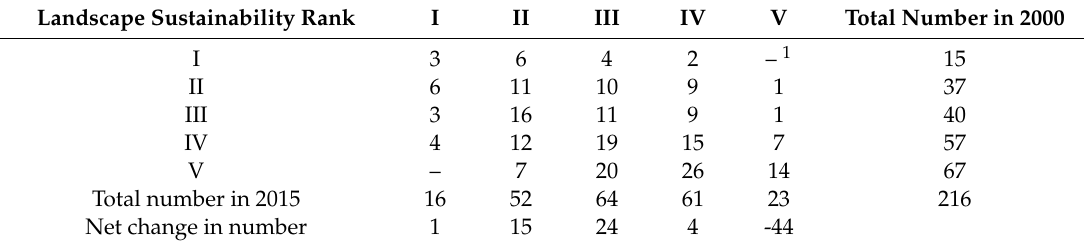
Table 2. Transition matrixes of landscape sustainability of basins during 2000–2015.